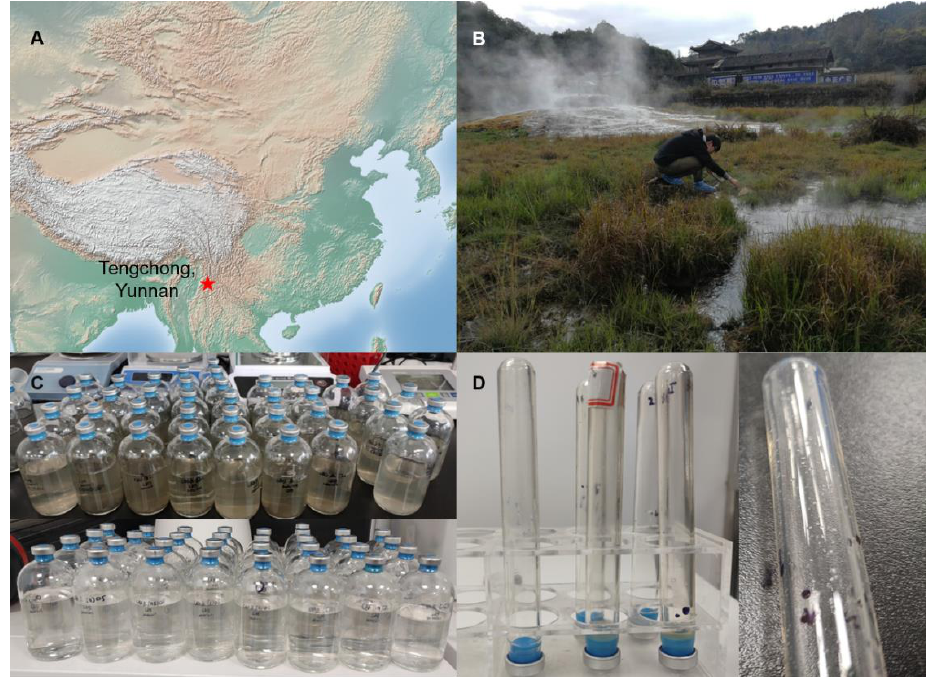
Figure 1. Sampling, enrichment, and isolation of methanogens from hot spring sediments. ( A ) Tengchong is located in the Yunnan province in Southwest China. ( B ) The sampling site was a natural hot spring and the sediments were brownish. ( C , D ) We enriched methanogens with methanogenesis substrates, and isolated methanogens using Hungate rolling tubes.